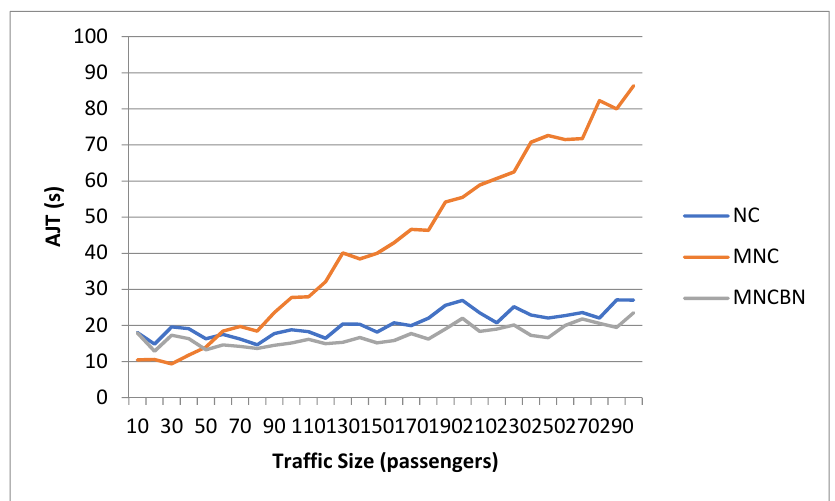
ffi c size. Energies 2020 , 13 , x FOR PEER REVIEW